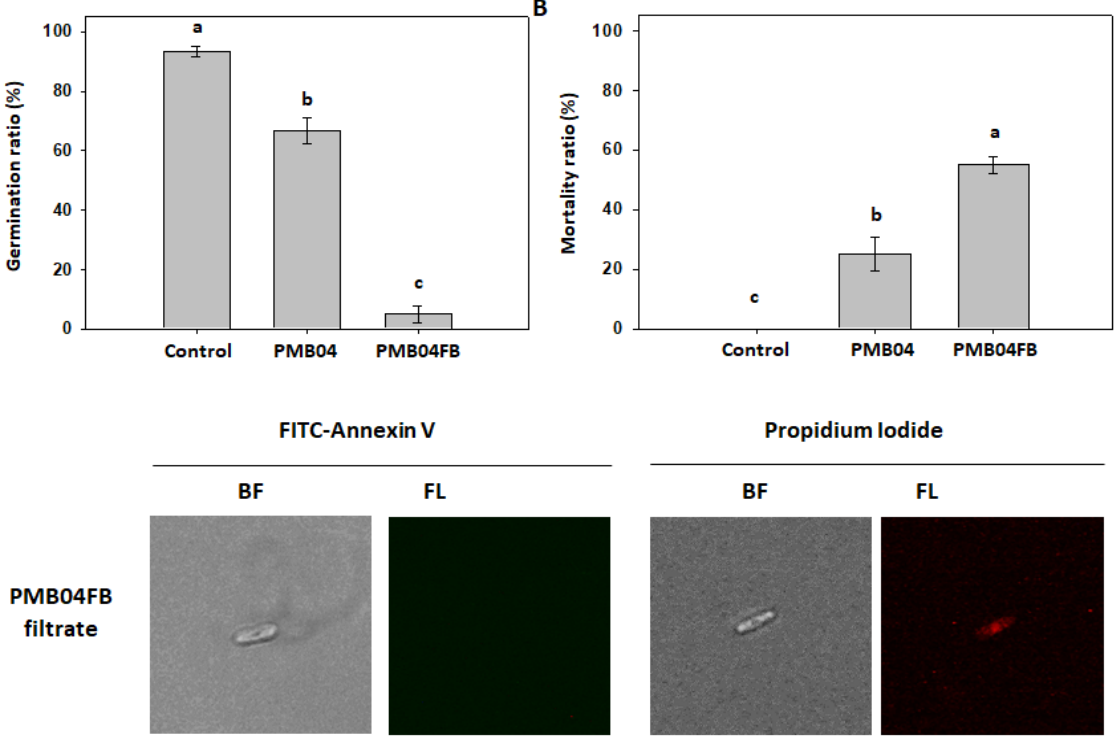
Figure 3. B. amyloliquefaciens PMB04 inhibition of Colletotrichum gloeosporioides conidia. ( A ) and ( B ) show the germination and mortality ratios of the bacterial suspension (PMB04) and 200-fold dilution of PMB04 fermentation broth (PMB04FB) on conidia at 12 h post treatment, respectively. Sterilized water was used as a negative control. Data represent mean ± SD, and different letters indicate significant differences by treatment based on Tukey’s HSD test (the F value for germination ratio and mortality ratio were 54.0 and 201.0, respectively. p < 0.05). ( C ) shows the treated conidia under bright field (BF) and fluorescence (FL). The conidia were stained with FITC-annexin V and propidium iodide in the FL images.